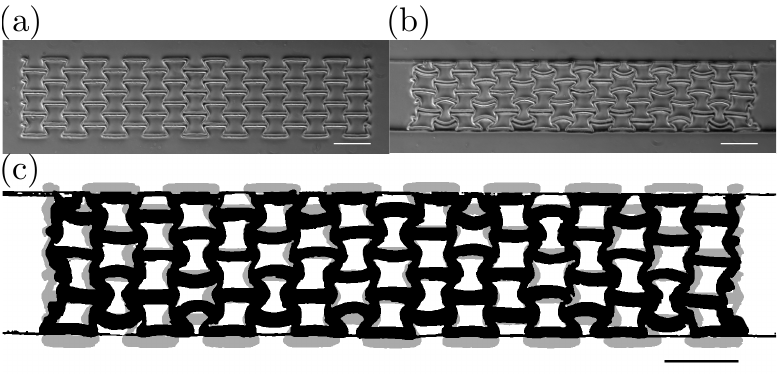
Figure 6. Auxetic metamaterial fabricated from a solution of 90 % PEG-DA M n = 700 g/mol and 10 % photo-initiator in volume. ( a ) Before compression, ( b ) submitted to an uniaxial compression, ( c ) superposition of the undeformed and deformed shapes. The particle width and length decreased when compressed, which is indicative of a negative Poisson’s